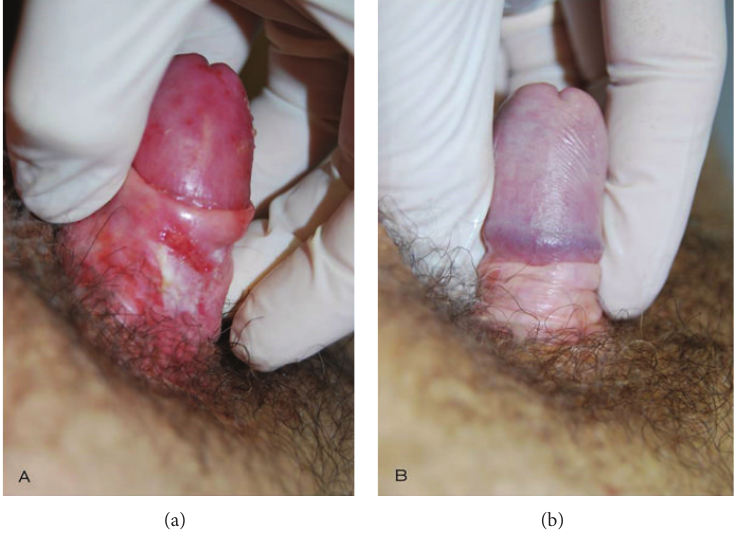
Figure 2: Complete resolution of lichenoid inflammatory area and preputial